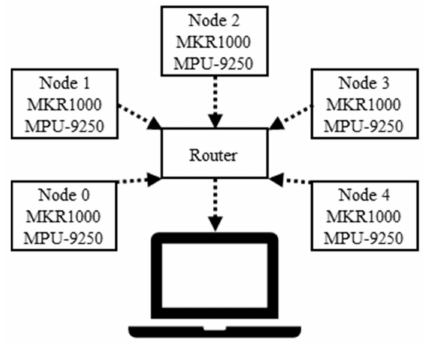
Figure 4. Block diagram of the star network; dashed arrows represent wireless links.